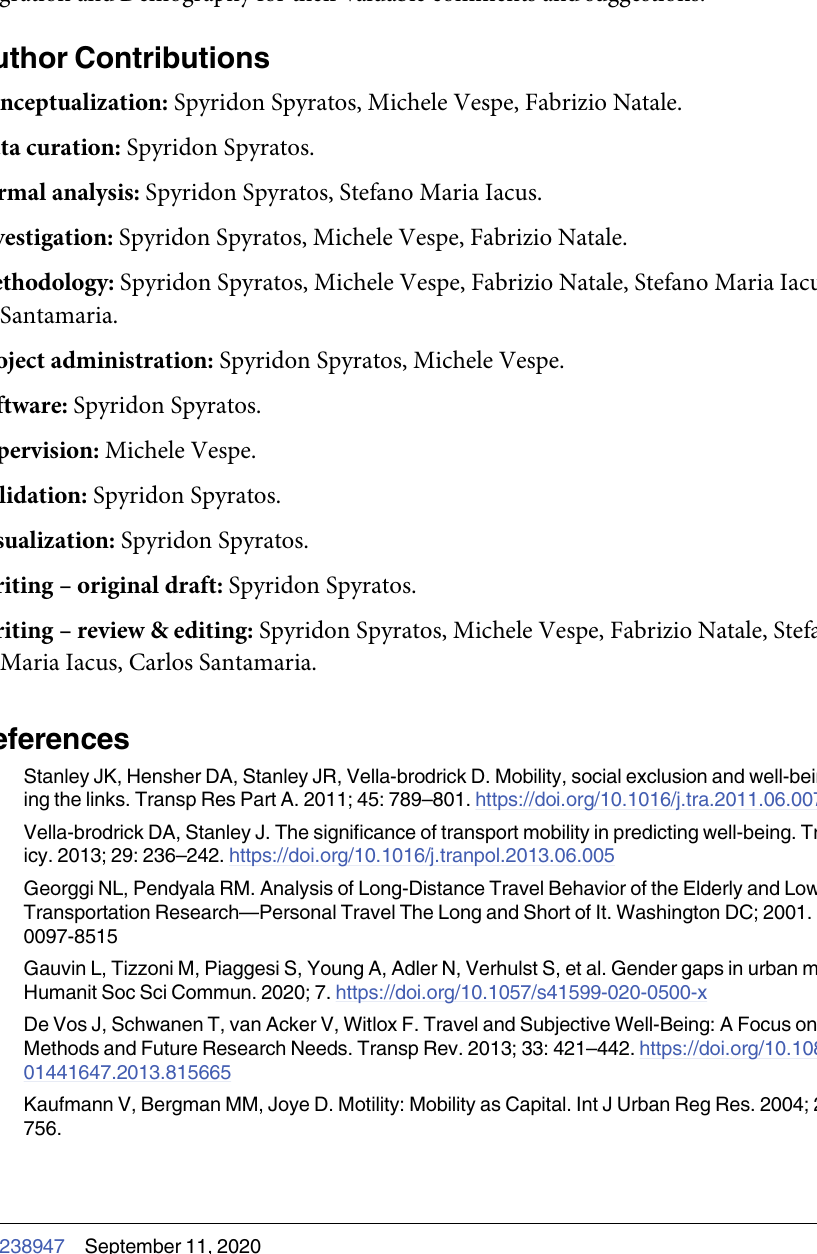
S1 Table. List of countries of previous residence for which Facebook provides audience